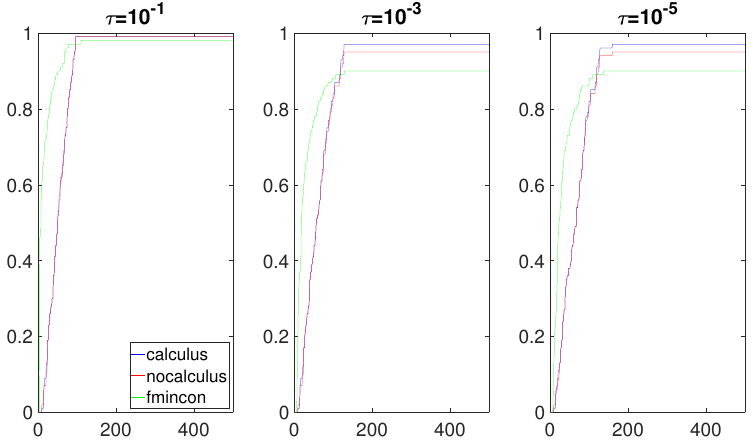
Figure 2. Data profiles when F = f 1 · f 2 , f 1 is a quadratic function, and f 2 is a linear